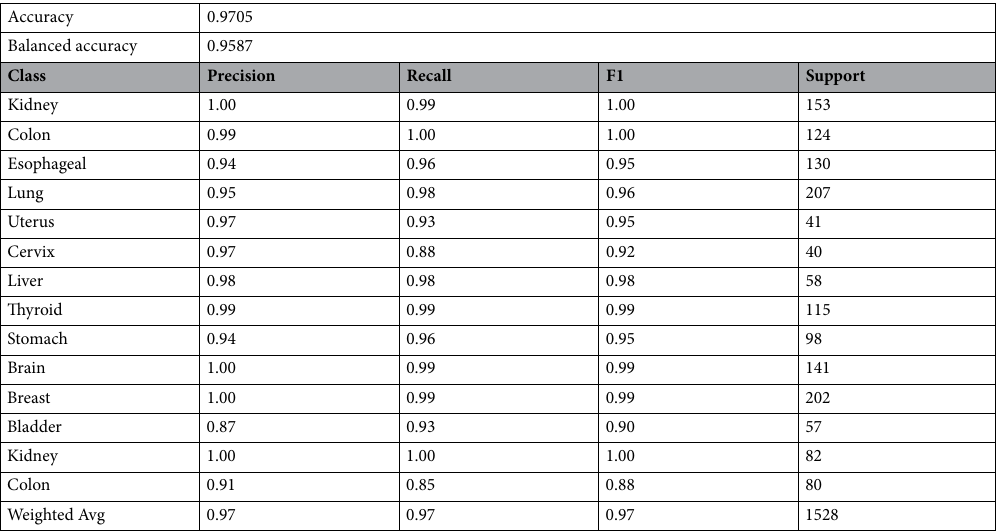
Table 2. Tissue origin